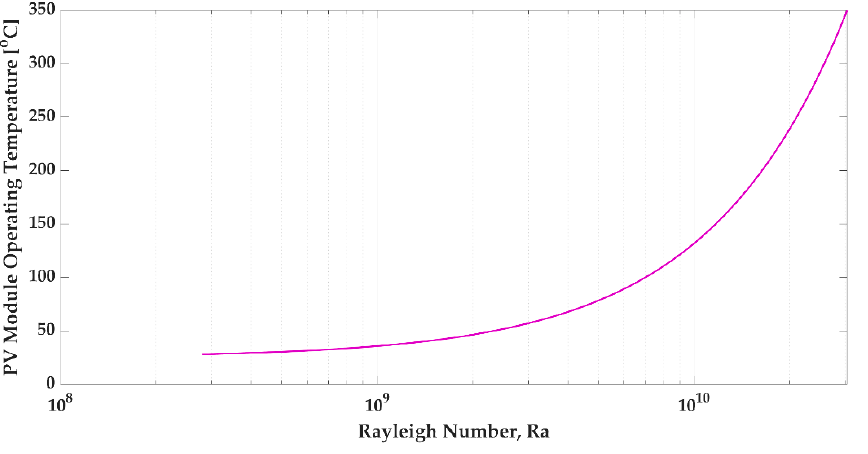
Figure 3. Rayleigh number variation at horizontal θ = 0 ◦ against PV module operating temperature with various solar flux at γ = 90 ◦ .